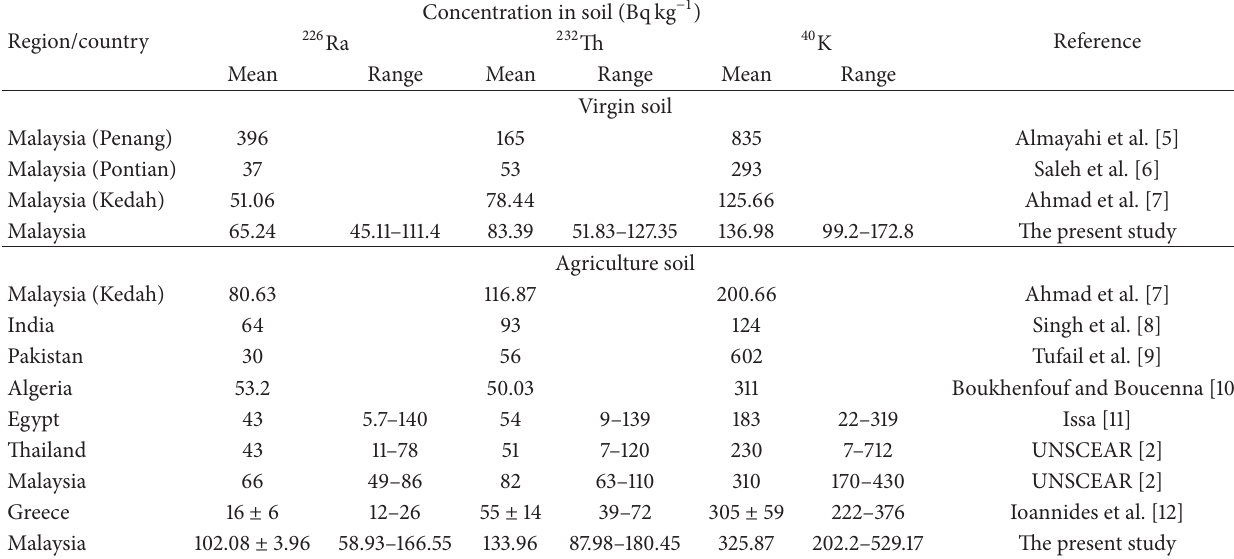
Table 3: The mean activity concentrations of natural radioactivity of agriculture and virgin soils in the present study were compared with those from similar investigations performed in other